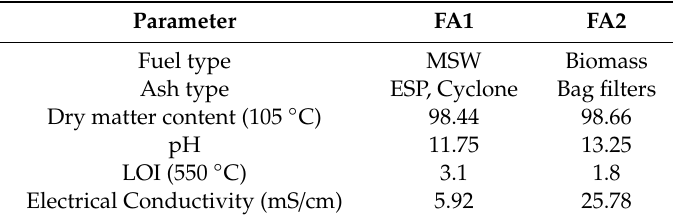
Table 1. General characteristics of fly ash.